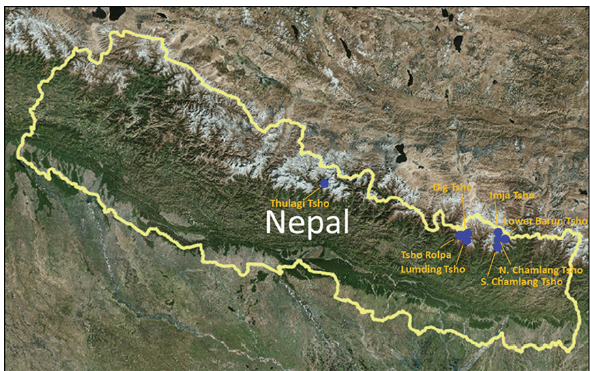
Figure 1. The locations of the eight glacial lakes assessed in this study in the Nepal